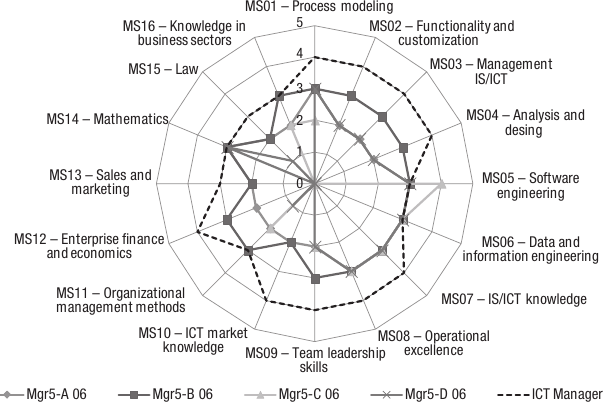
Fig. 5. Knowledge offered by master’s study fields vs demand for knowledge by economic entities for the role of ICT manager in 2006. Source: authors.